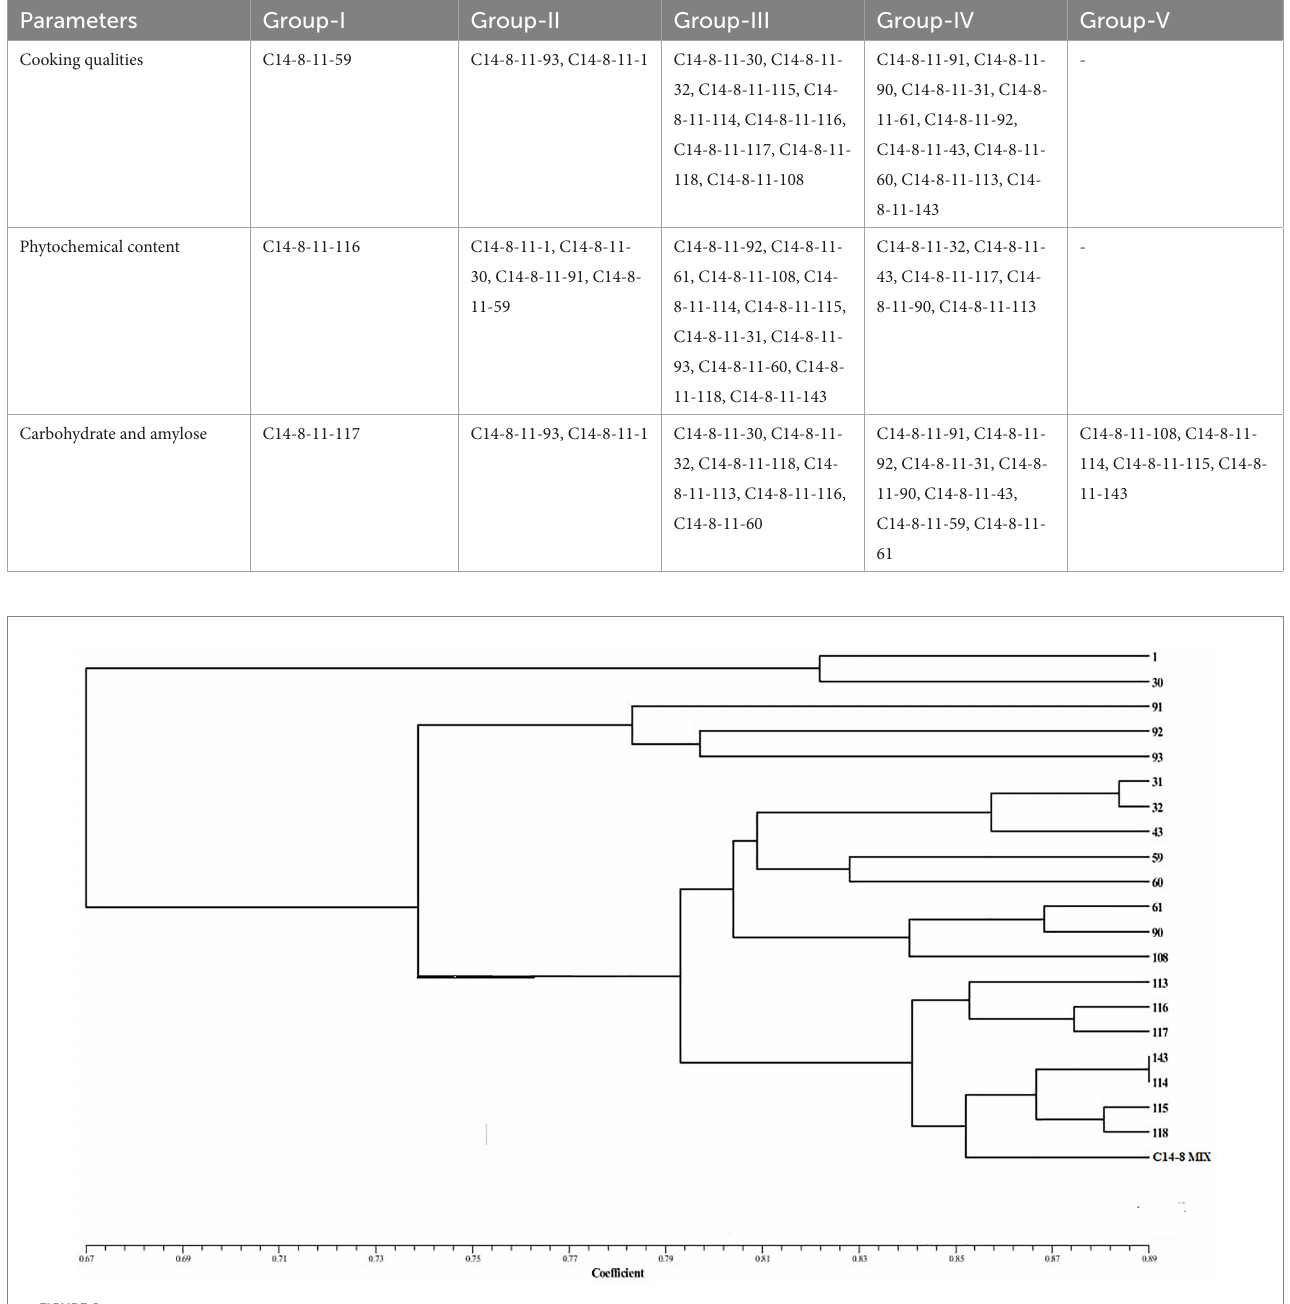
FIGURE 6 Dendrogram showing molecular